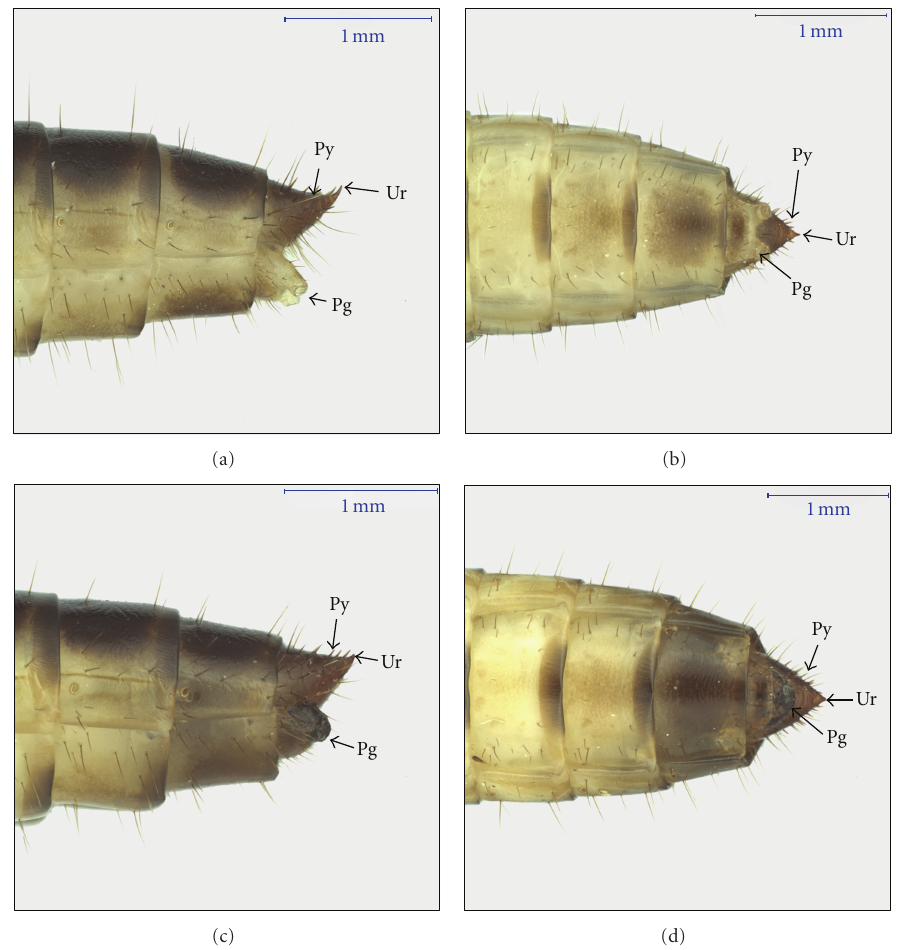
Figure 1: External posterior characteristics of late-instar A. diaperinus : with prominent pygopods ((a) lateral view and (b) ventral view) and unapparent, or much reduced, pygopods ((c) lateral view and (d) ventral view). Pg, pygopod; Py, pygidium; Ur,